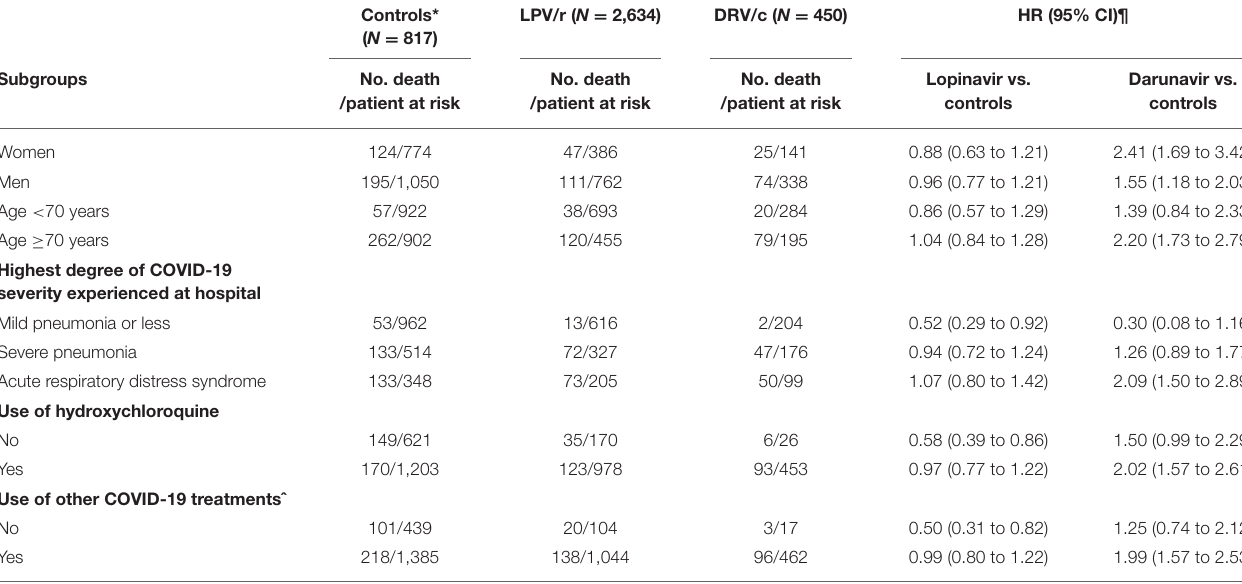
TABLE 3 | Hazard ratios for mortality according to lopinavir/ritonavir (LPV/r) or darunavir/cobicistat (DRV/c) use, in different subgroups. Subgroups No. death